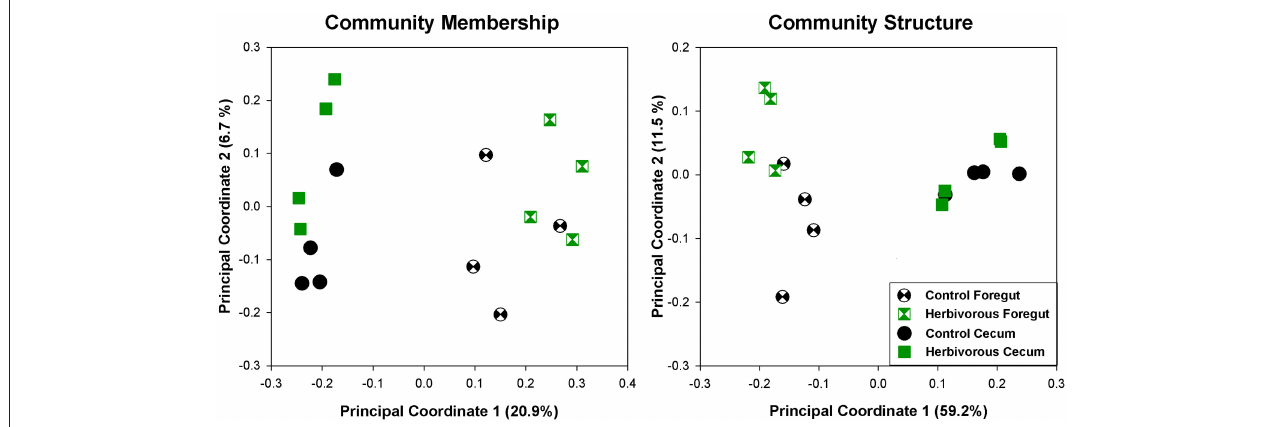
FIGURE 5 | Principal coordinate analyses of foregut and cecal communities of control and herbivorous-selected voles. Community membership uses unweighted UniFrac distances, and thus investigates the presence or absence of bacterial lineages. Community structure uses weighted UniFrac distances, which takes relative abundances of taxa into account. The points for cecal samples represent the same samples as presented in Figure 3 , except here we used a lower number of sequences per sample for analysis, due to a slightly lower return of sequences from some foregut samples.